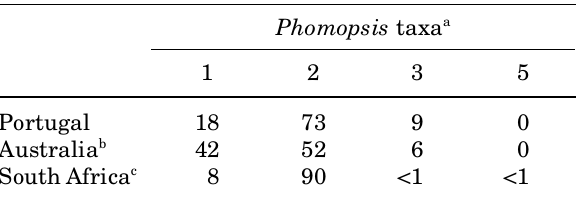
Table 4. Frequencies (percentages) of Phomopsis taxa reported from grapevines in Portugal, Australia and South